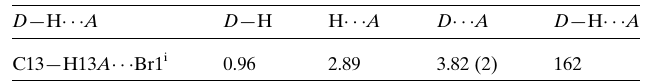
Table 2 Experimental details.